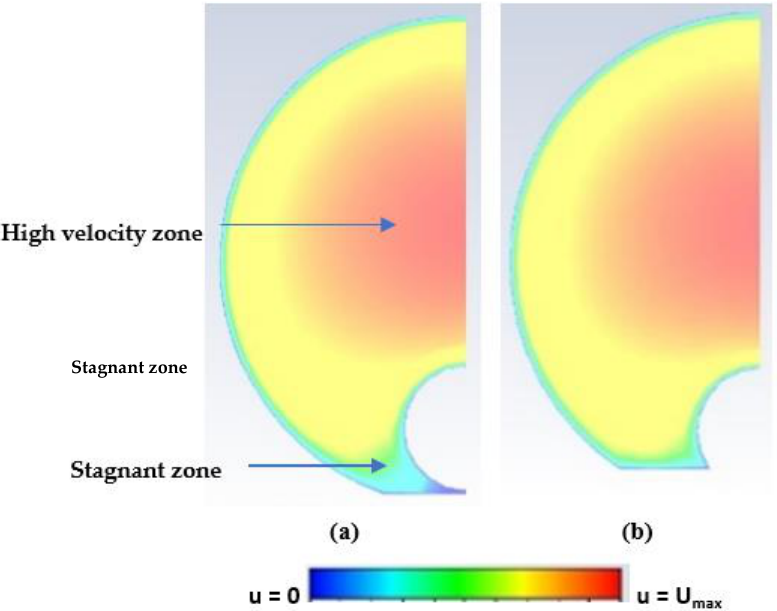
Figure 8. Velocity distributions in partially blocked annuli for case 𝒏 = 1, 𝛋 = 0.25, 𝒆 = 0.9, 𝑸 = 5 × 10 −5 m 3 /s and different bed hieghts: ( a ) H bed = 10%; and ( b ) H bed = 30%.